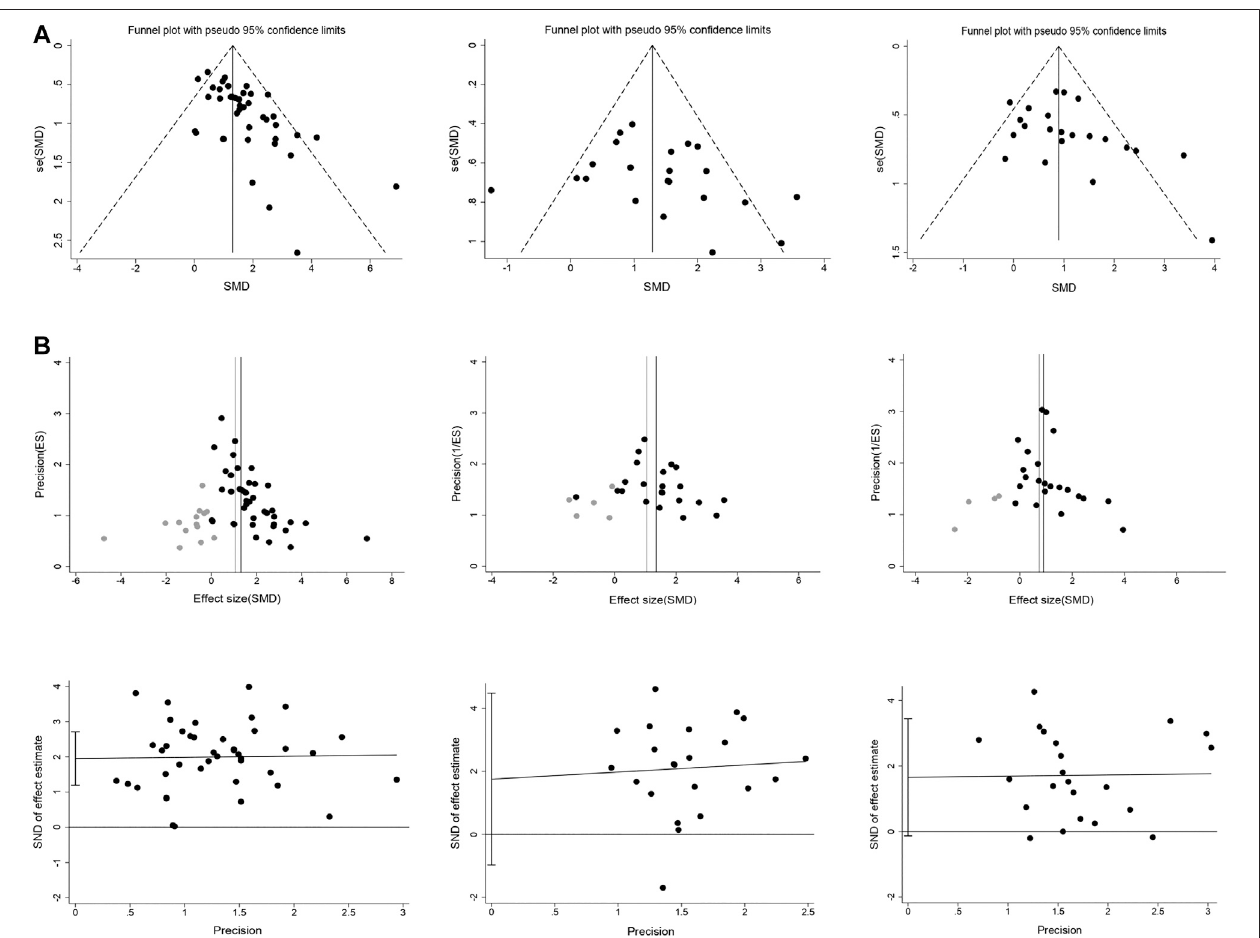
FIGURE 6 | Publication bias assessment. Funnel plots (A) for intracerebral hemorrhage, infarct size, and neurobehavioral score showing the publication bias. Trim and fi llanalysis (B) showedthedistributionofpublishedstudyoutcomes(blackcircles)andimputedoutcomes(graycircles)inintracerebralhemorrhage,infarctsize,and neurobehavioral score. The vertical black lines represent the actual estimate and the gray vertical lines represent the theoretical estimate when publication bias does not exist. Egger ’ s regression (C) for intracerebral hemorrhage, infarct size, and neurobehavioral score con fi rming potential evidence for publication bias. The short vertical lines represent the 95% con fi dence